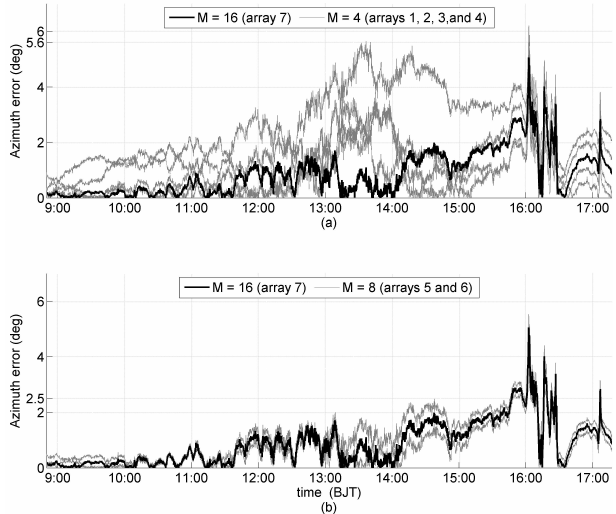
Figure 8. Experimental errors of the solar azimuth angle, with a thick black line generated by Array 7 ( M = 16), and thin gray lines generated by: ( a ) Arrays 1, 2, 3, and 4 ( M = 4); and ( b ) Arrays 5 and 6 ( M =